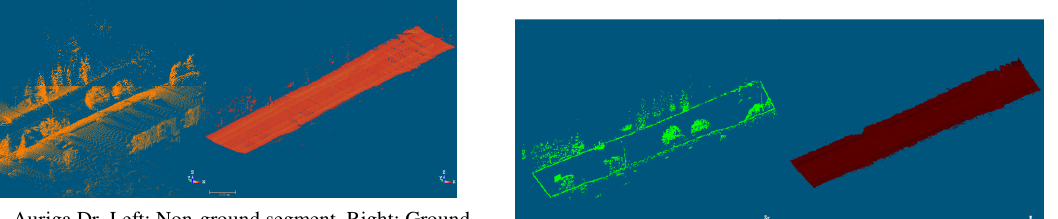
Figure 8. Auriga Dr. Left: Non-ground segment. Right: Ground segment.